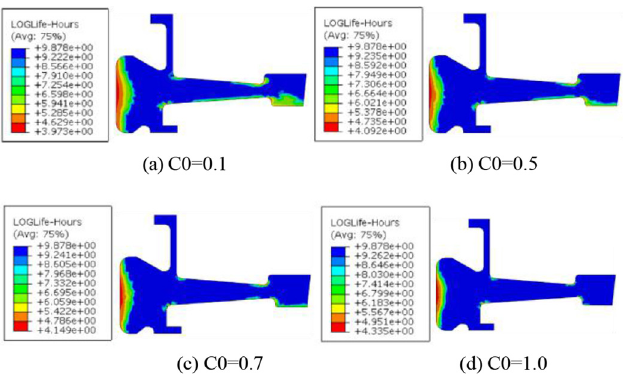
Fig. 14. Distribution diagram of the logarithmic fatigue life of the turbine disc with different values of the parameter C0: (a) C0 = 0.1, (b) C0 = 0.5, (c) C0 = 0.7, and (d) C0 = 1.0.